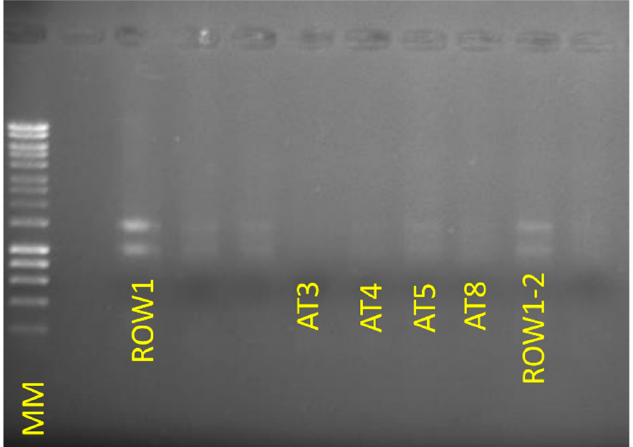
Figure 2. Agarose gel electrophoresis of RNA extractions from all samples in this study except for sample AT2. The molecular marker (MM) used was GeneRuler 1kb plus (ThermoFisher). For each sample, 6 µ L of extracted RNA was loaded into each well. One sample, AT2, was not included in this electrophoresis gel.